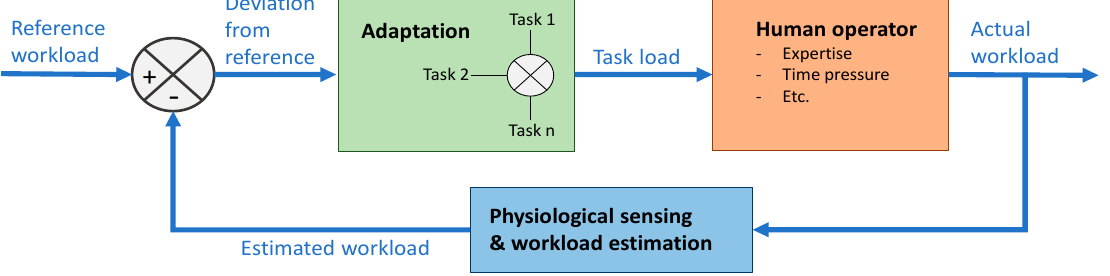
Figure 1. Negative feedback loop for passive control of a system.